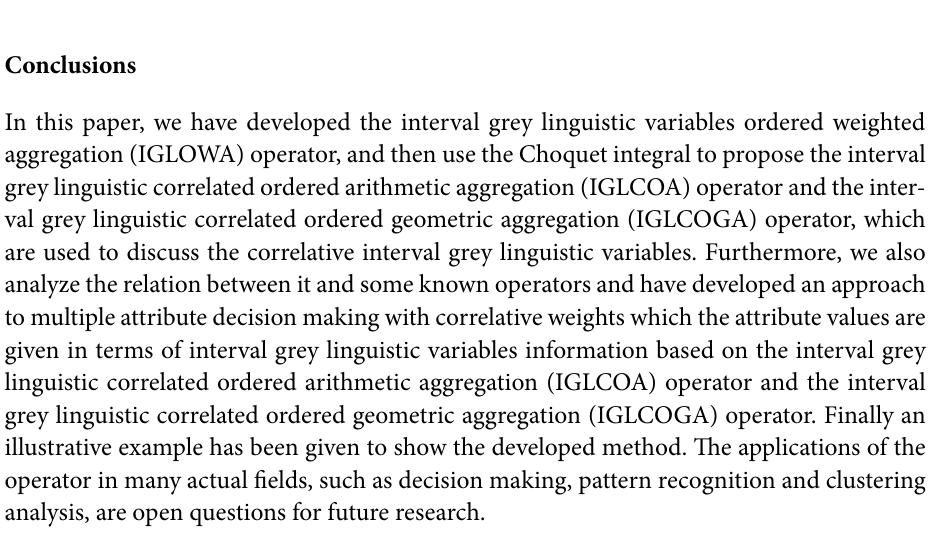
Ordering (Using IgLCOga